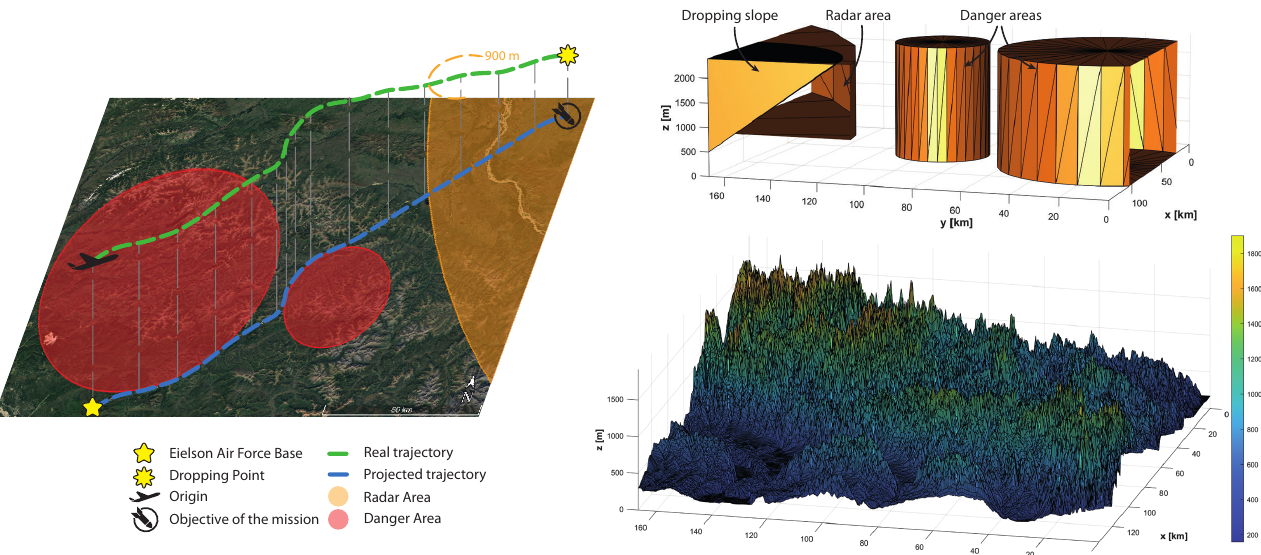
Figure 2. Initial and final points of the mission and restriction areas ( left ). Obstacles of the danger and radar areas and the dropping slope ( top right ), as well as the ground elevation ( bottom right